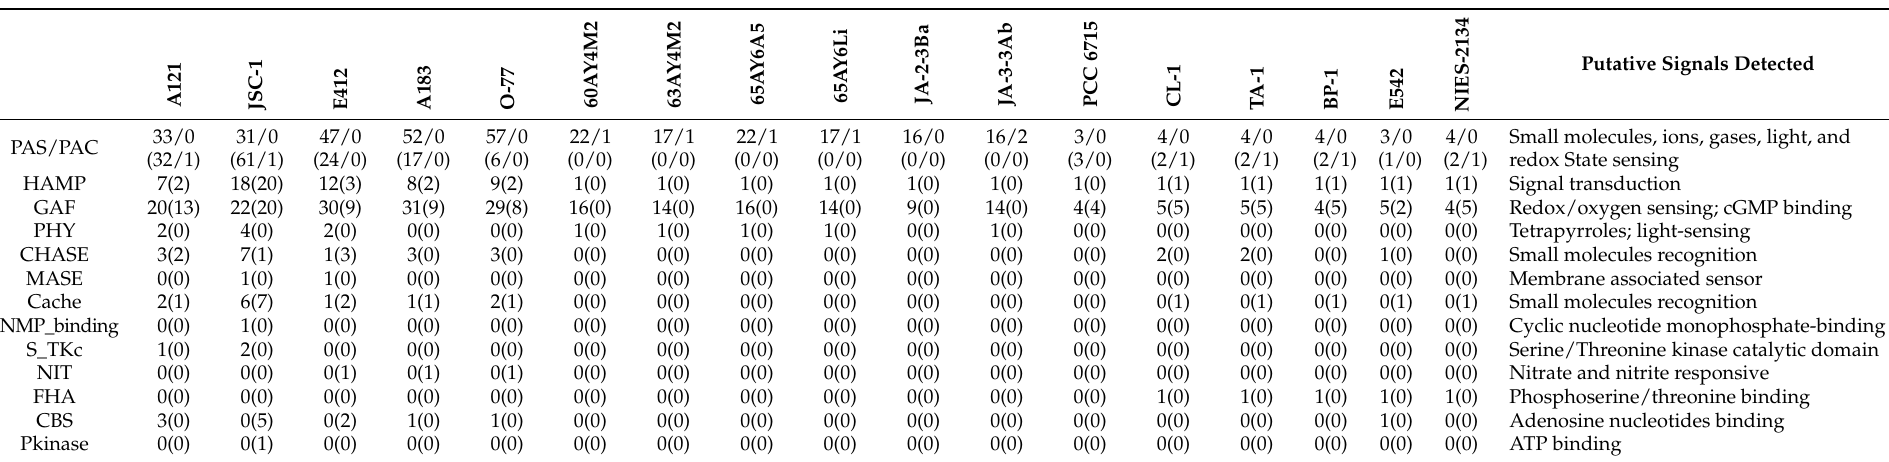
Table 3. Sensing domains detected in HKs of thermophilic cyanobacteria studied. Number before and within brackets referred to the number of corresponding categories in cHK and hyHK,